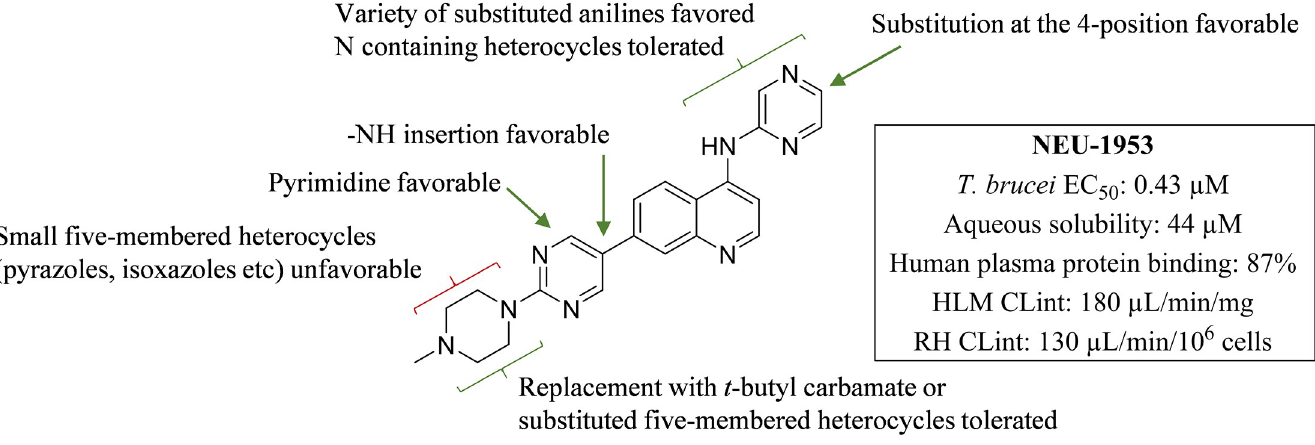
Fig 7. SAR summary around this series for potent anti T . b . brucei